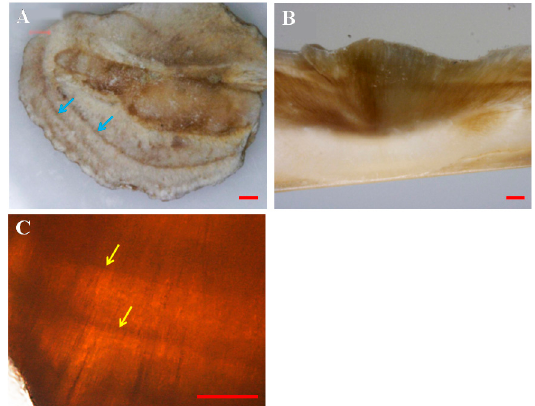
Figure 3. Micrograph of Diaphus gigas Gilbert. The longer period of incremental lines was observed ( A , blue arrows). The narrower incremental lines were unclear, as well as the long-period incremental lines ( B , C ). The long-period of incremental lines (average 49 μ m: yellow arrows) were observed ( C ). Digital microscopy images ( A : otolith surface, B : cross-sectional image). Polarizing micrograph of the ground specimen ( C ). Scale bar: 500 μ m ( A ), 100 μ m ( B ), 50 μ m ( C ).